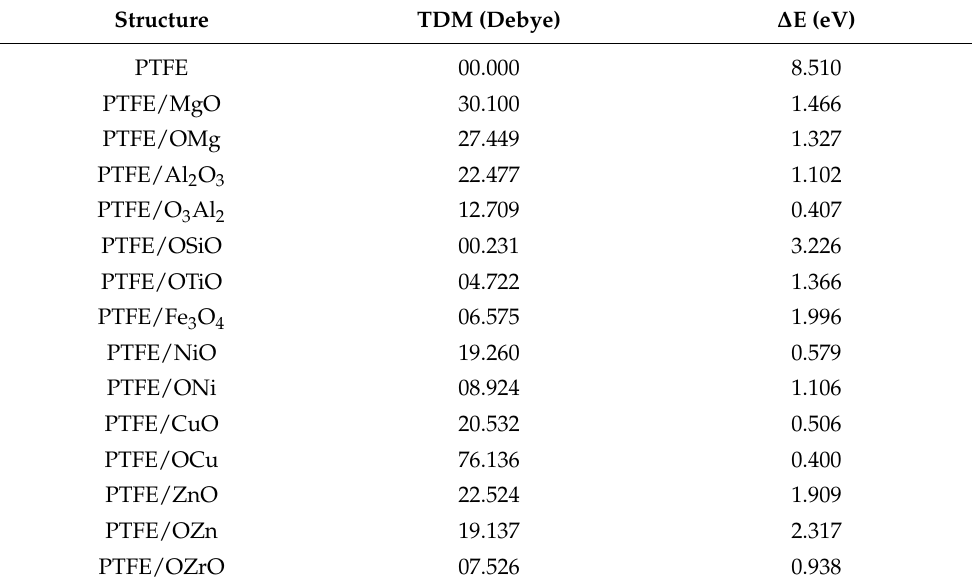
(MgO, Al 2 O 3 , SiO 2 , TiO 2 , Fe 3 O 4 , NiO, CuO, ZnO, and ZrO 2 ) using B3LYP/LANL2DZ.